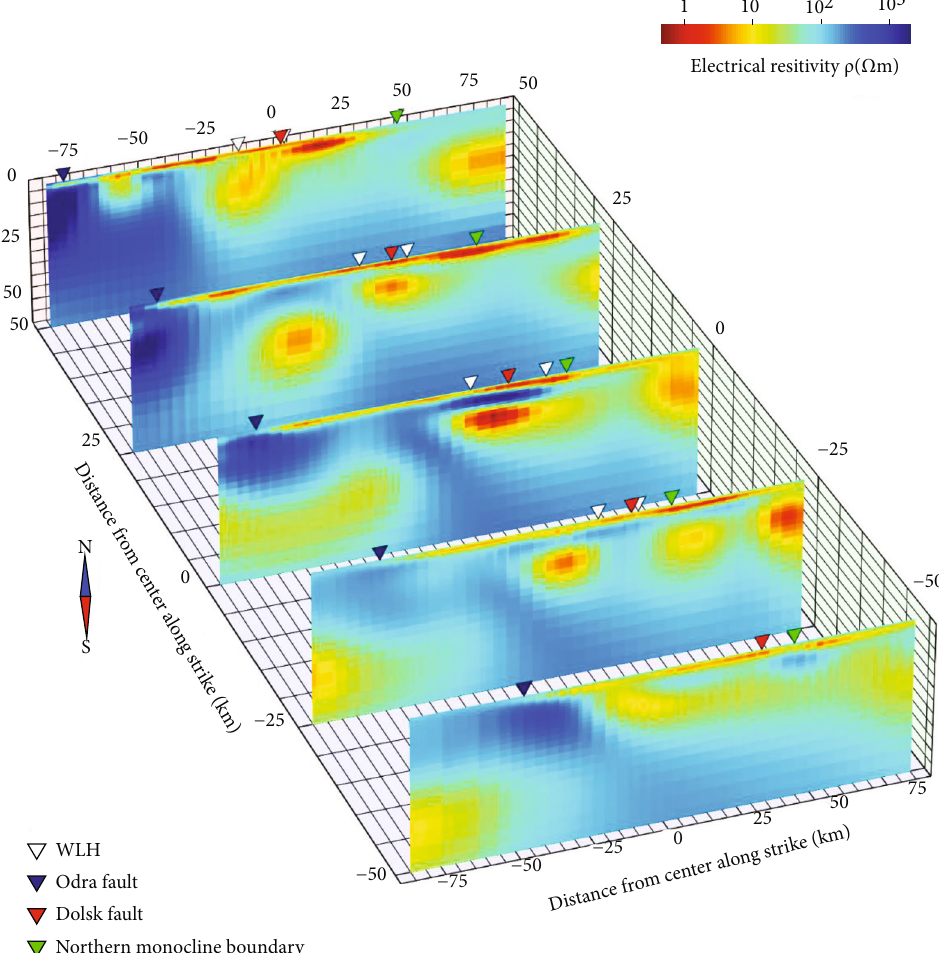
Figure 12: The presentation of 3D NLCG inversion results in the depth range from 0 to 50km on individual pro fi